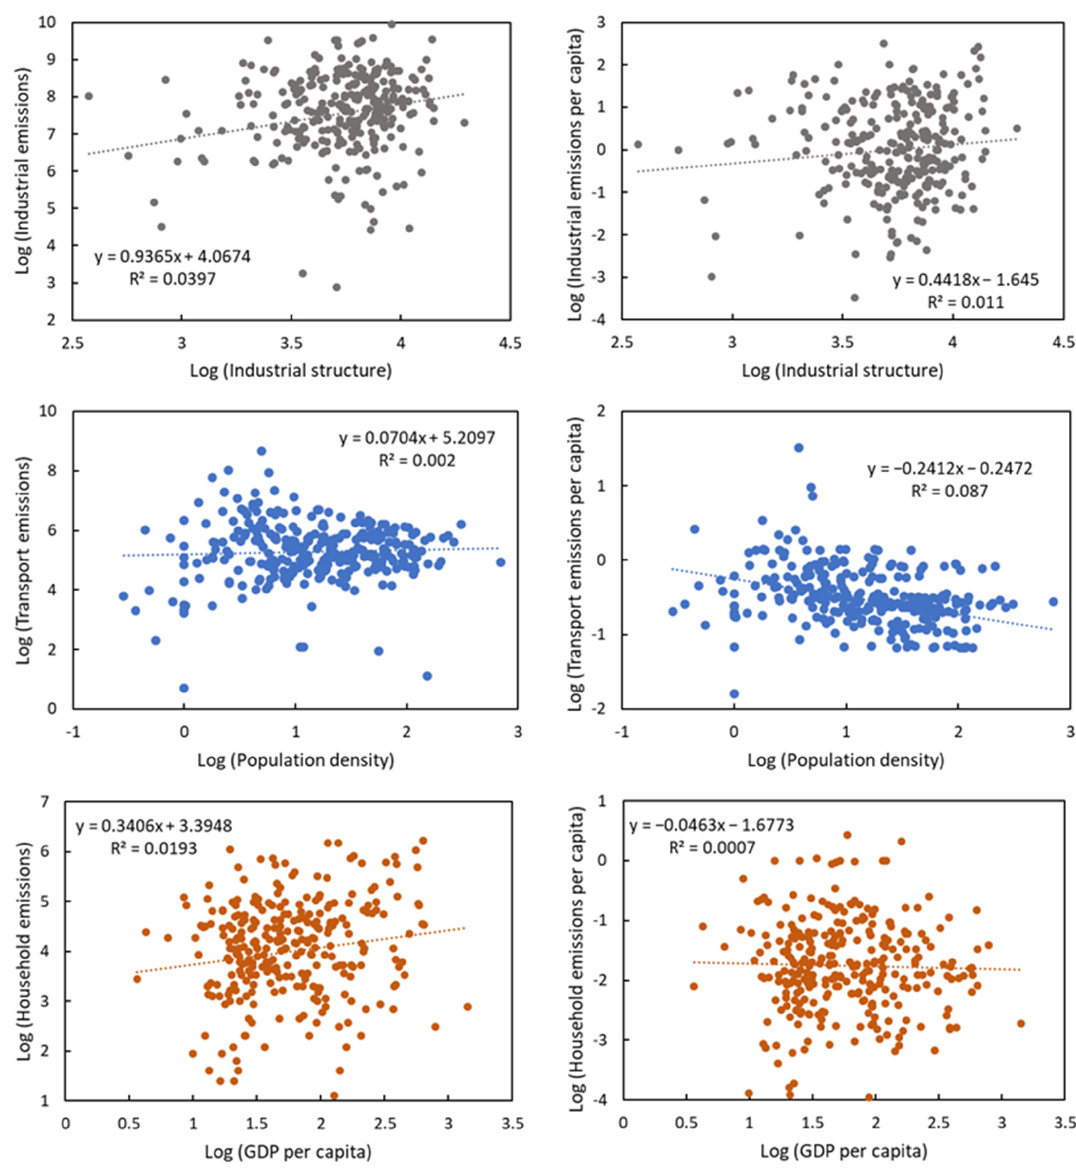
Figure 3. Scatter plots between CO 2 emissions and socio-economic factors in Chinese cities. multiple regression models on diverse emission sectors and emission efficiency indicators (Table 1). The dependent variables in the regression equation are the logarithm of CO 2 emissions, and the independent variables are the logarithm of socio-economic features, including GDP, per capita GDP, industrial structure, and population density. Those models were tested significantly, indicating a linear regression relationship between socio-economic features and CO 2 emissions. According to the fitness reflected by the adjusted R square, socio-economic features can better explain the total emissions and household emissions compared to other emission